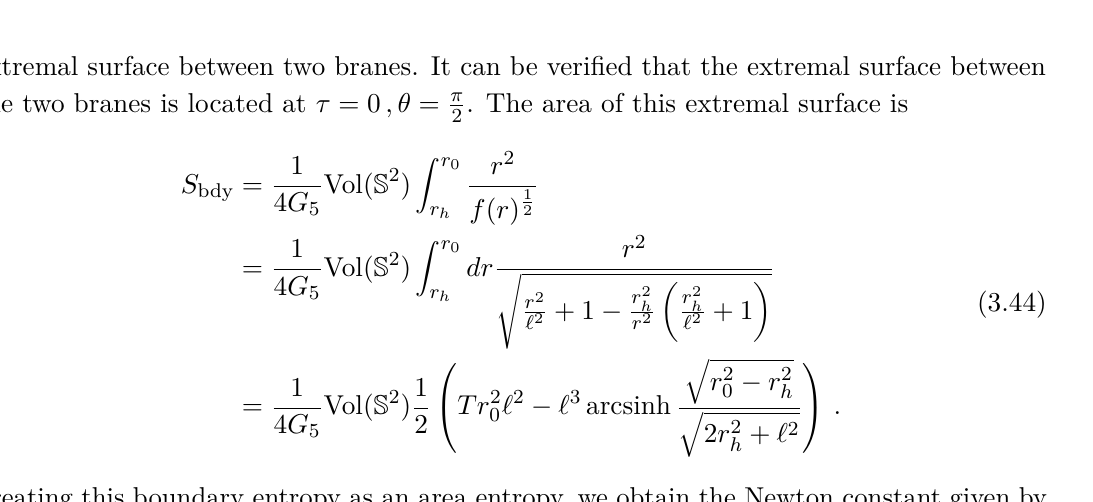
Figure 15 . Left: RT surface for entangling surface at θ = π after partial